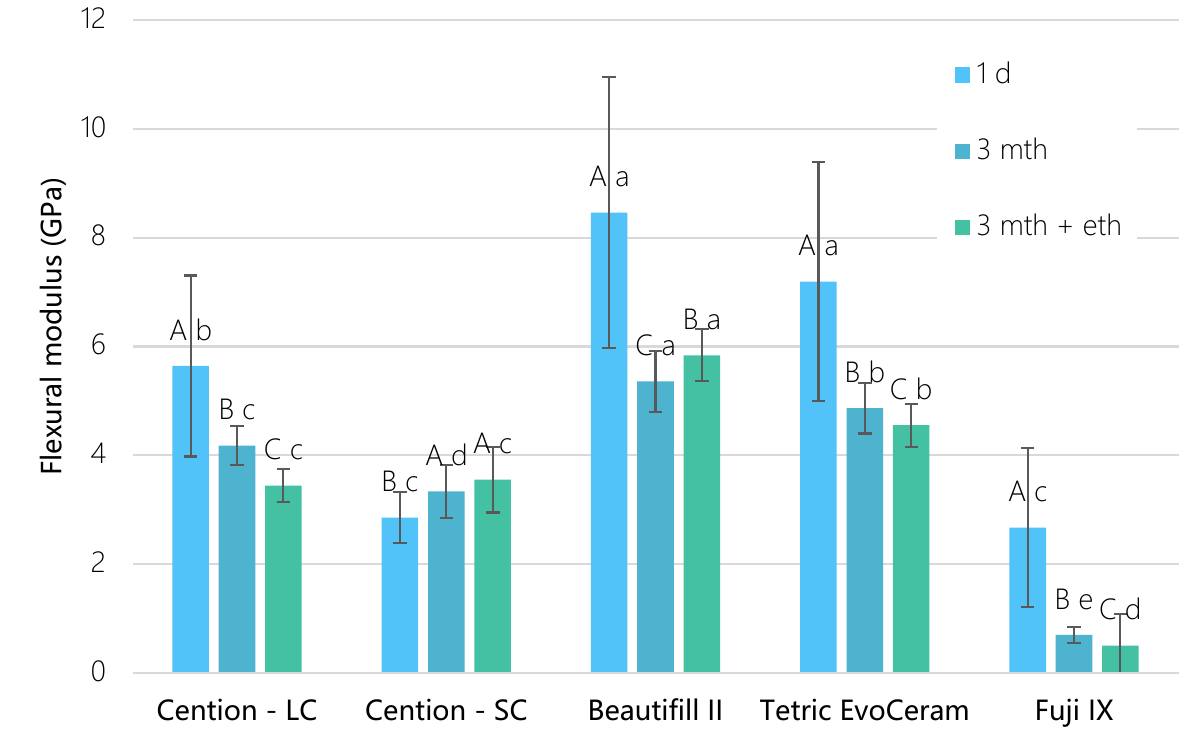
Figure 3. Flexural modulus as a function of time for tested materials (mean values ± standard deviation, n = 20). Identical uppercase letters denote p > 0.05 for the same material between different time points; identical lowercase letters denote p > 0.05 between materials at the same time point.